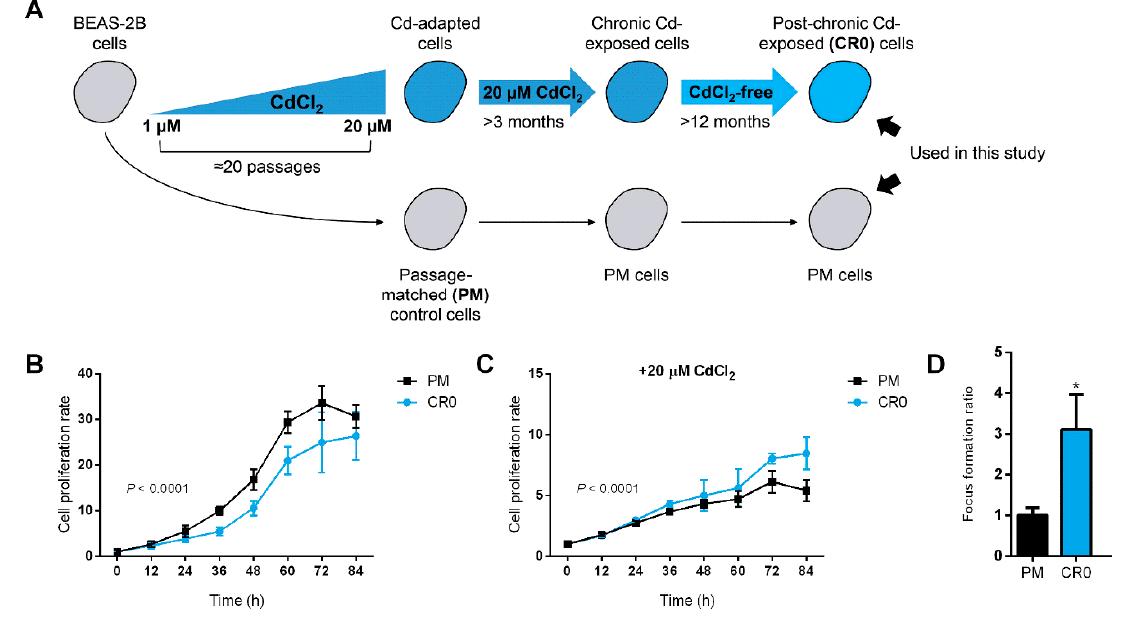
Figure 1. Establishment of a post-chronic Cd-exposed human lung cell line and evaluation of its Cd-resistance and DNA damage and repair capacity. ( A ) Schematic of the establishment of chronic and post-chronic Cd-exposed BEAS-2B cell line used in the previous [19] and current study; the post-chronic Cd-exposed BEAS-2B cells are termed as “CR0” while the passage-matched control cells are termed as “PM”. ( B , C ) Cell proliferation rate of CR0 and PM cells grown in standard LHC-9 medium or culture medium containing 20 µ M CdCl 2 was measured by 3-(4,5-dimethylthiazol-2-yl)-5-(3-carboxymethoxyphenyl)-2-(4-sulfophenyl)-2H-tetrazolium (MTS) assay. Results are representative of at least three independent experiments, and error bars represent mean ± SD of at least three technical replicates. ( D ) Colony formation assay of PM and CR0 cells treated with 20 µ M of CdCl 2 and grown for 7–10 days.